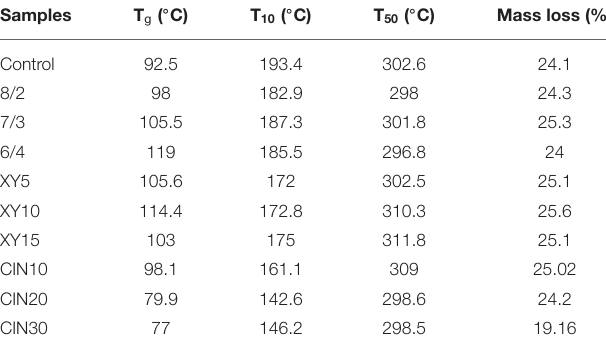
TABLE 1 | Thermal stability data for prepared